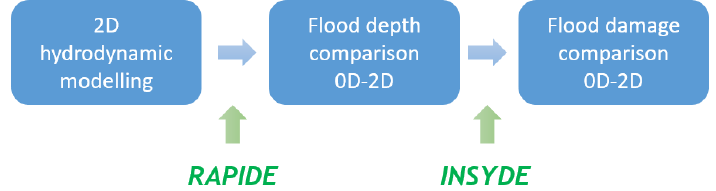
Figure 1. Workflow scheme of the paper.